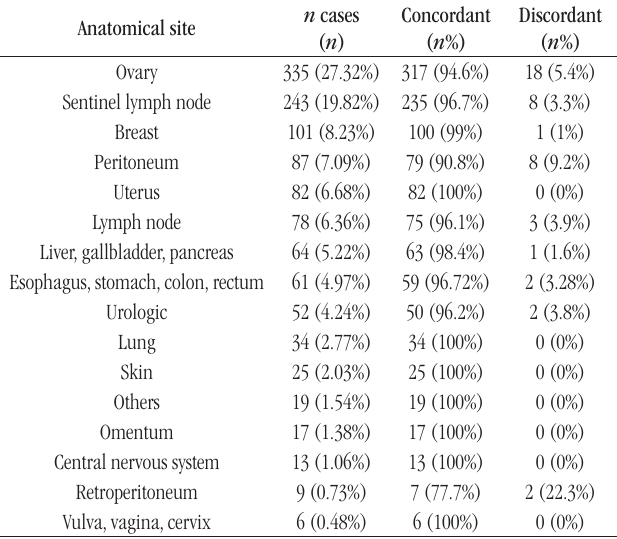
taBLE 1 − Accuracy in each of the evaluated anatomical sites ( n =